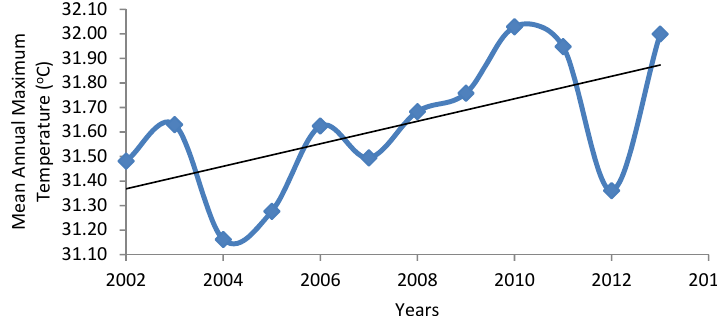
Fig. 8: The trend of the mean annual maximum temperature from 2002 until 2013 for Ikeja, Lagos